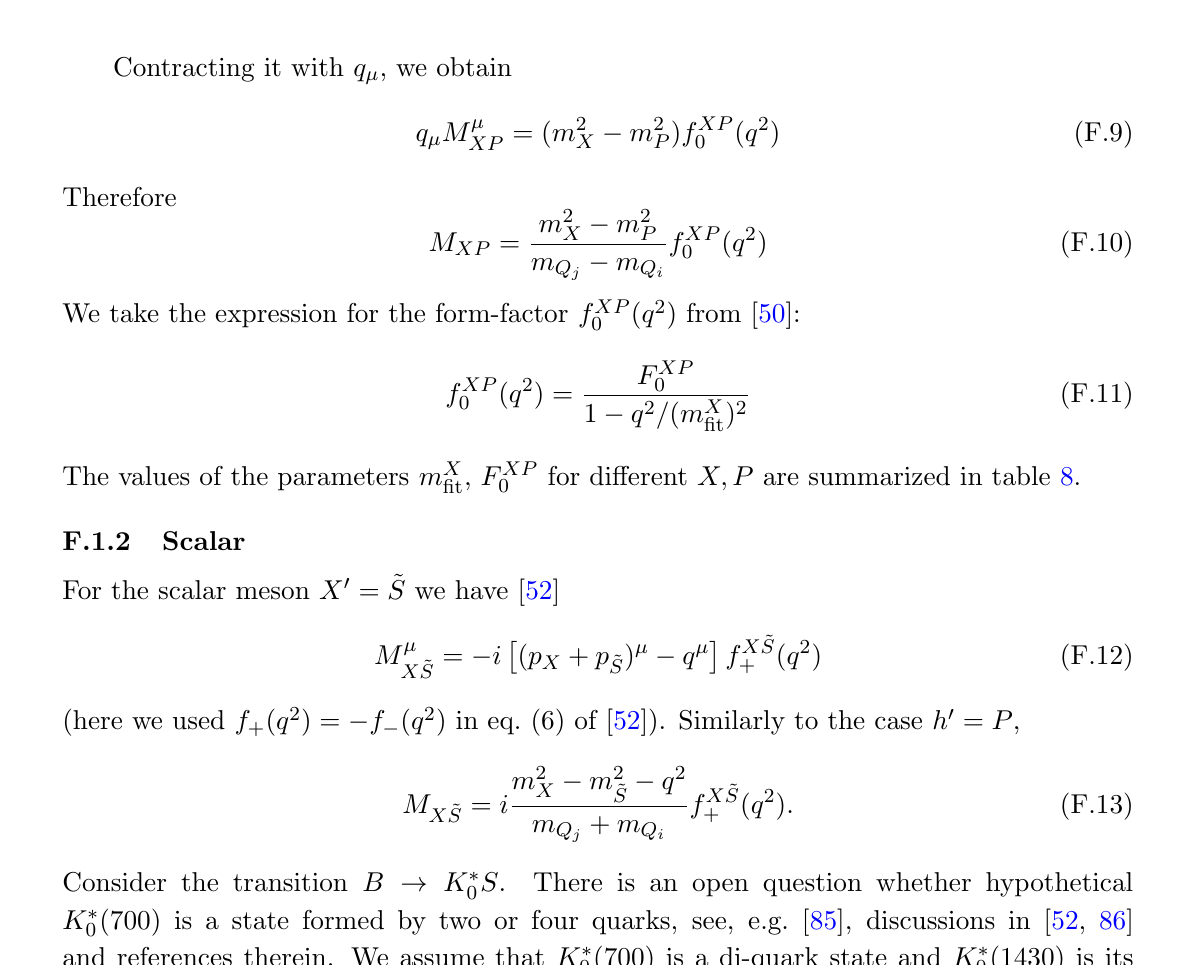
Table 8 . Values of the parameters in the form-factor (F.11) for di(cid:11)erent X; P . We use [50,